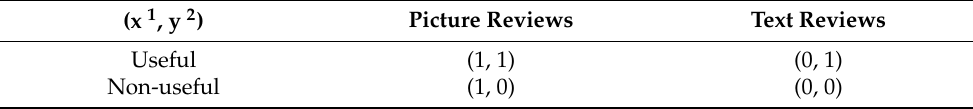
Table 6. Type of review—Usefulness. (x 1 , y 2